Question: Condense the content of this figure into a single sentence.
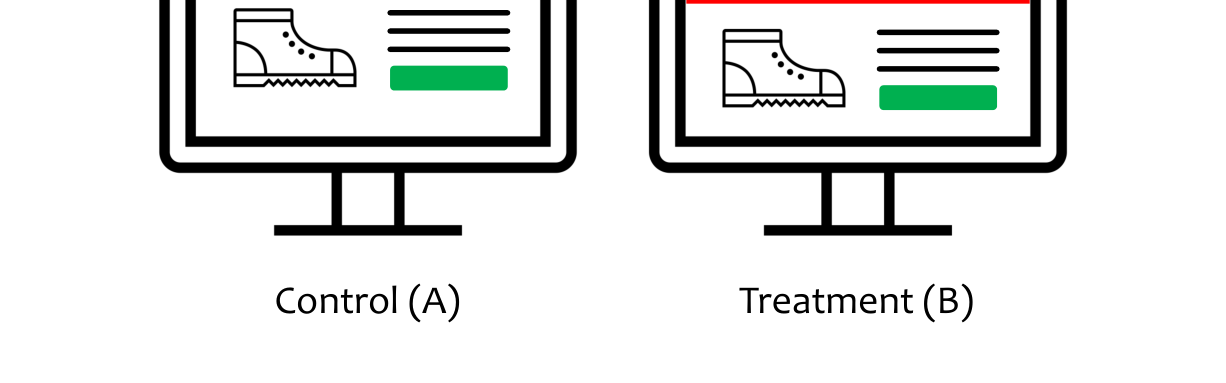
Answer: 1: Illustration of an A/B test (a randomised controlled trial with two parallel groups) designed to test the claim that “offering free delivery to users of an e-commerce website will lead to a larger proportion of the said users making a purchase.” Incoming users are split randomly into two groups, where one group (A) acts as the control, and the other group (B) is shown a ”free delivery” banner on the website as the treatment.